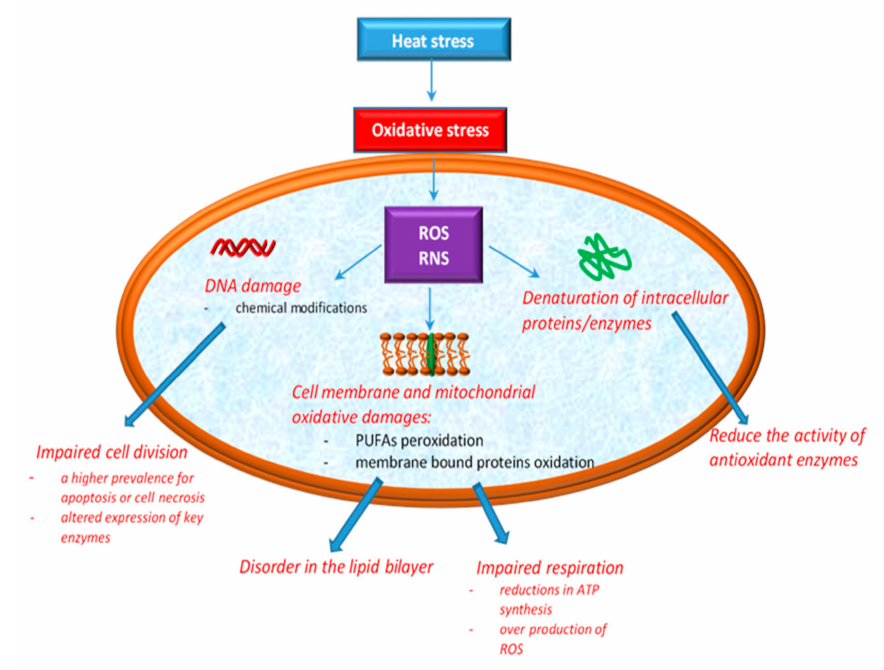
Figure 1. Cellular oxidative damage induced by heat